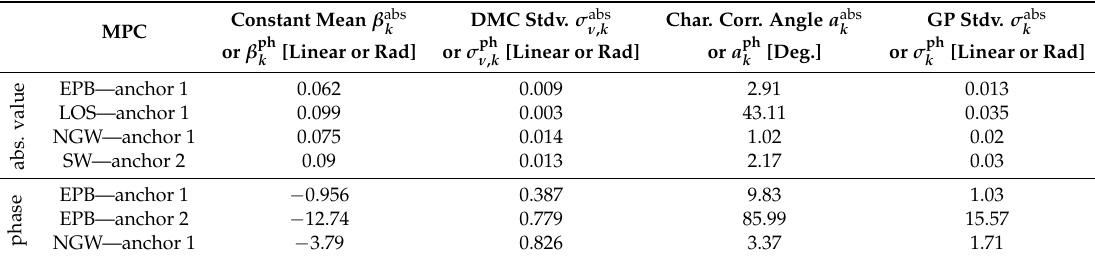
Table 1. Parameters of the Gaussian Process (GP) model for the absolute value of the specular multipath component (SMC)